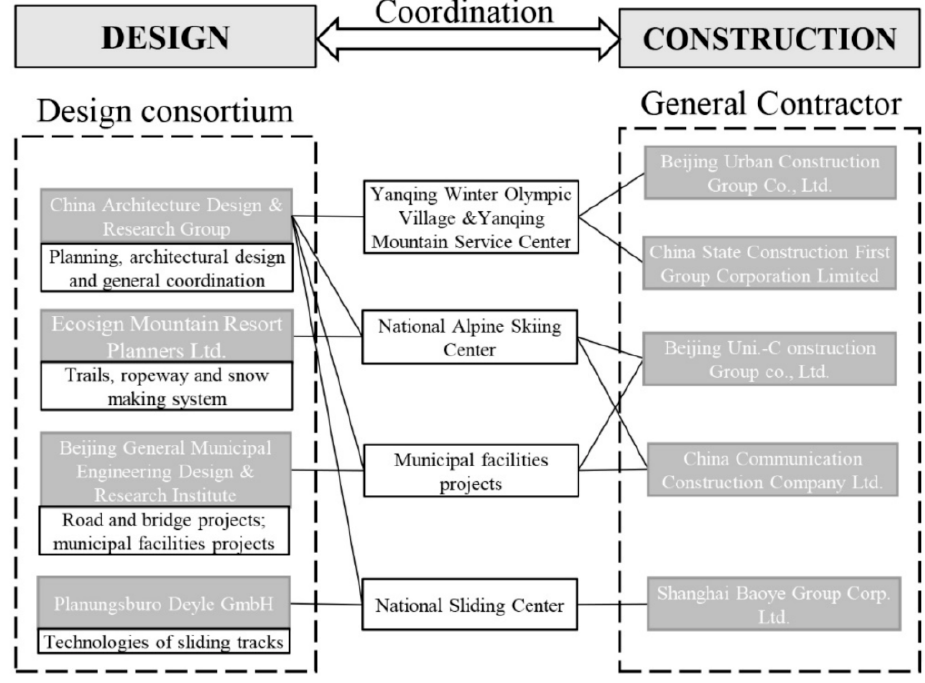
Figure 2. Design consortium and general contractors of the Yanqing Competition Zone [13].